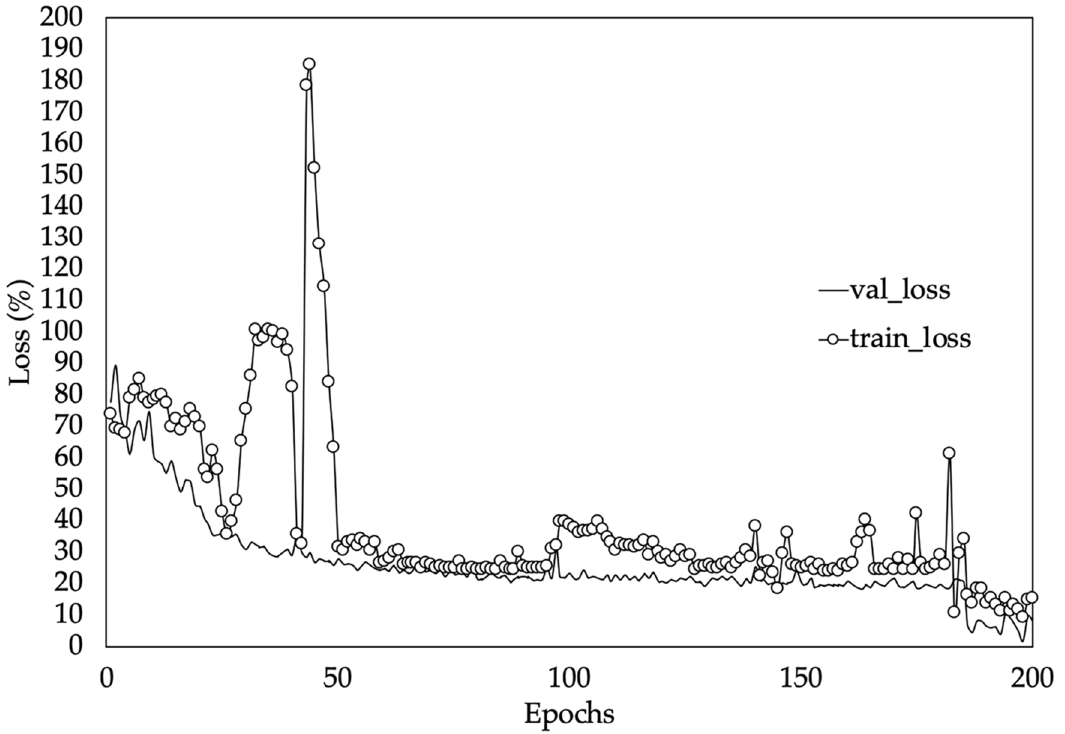
Figure 10. Training and validation loss values on dataset. Validation loss (val_loss) and training loss (train_loss).